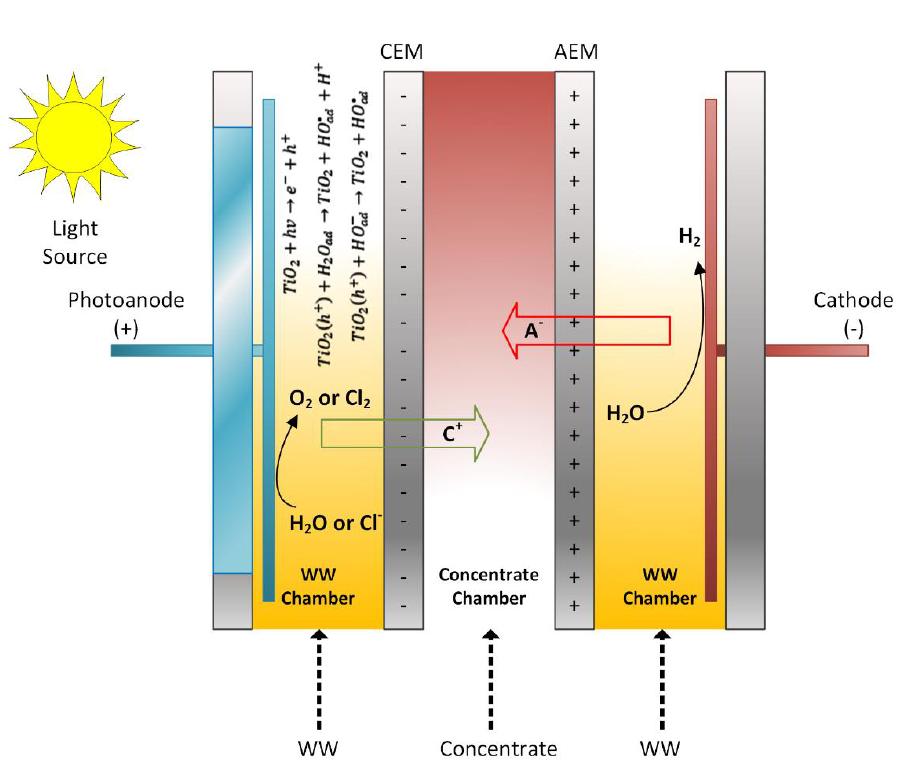
Figure 1. Reactor operation with the PECM